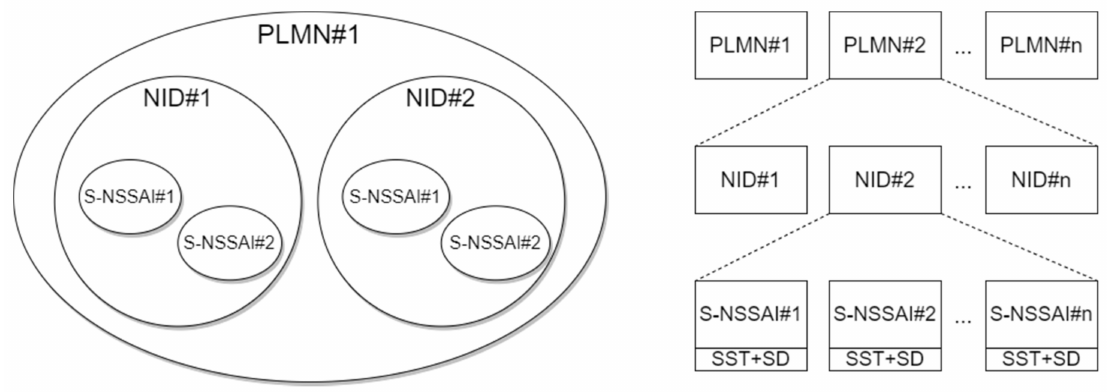
Figure 6. Hierarchy of network identifiers.